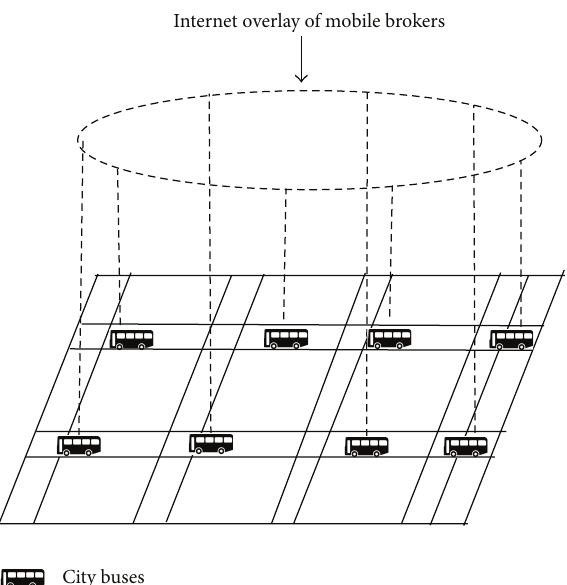
Figure 1: DHT of mobile brokers (city